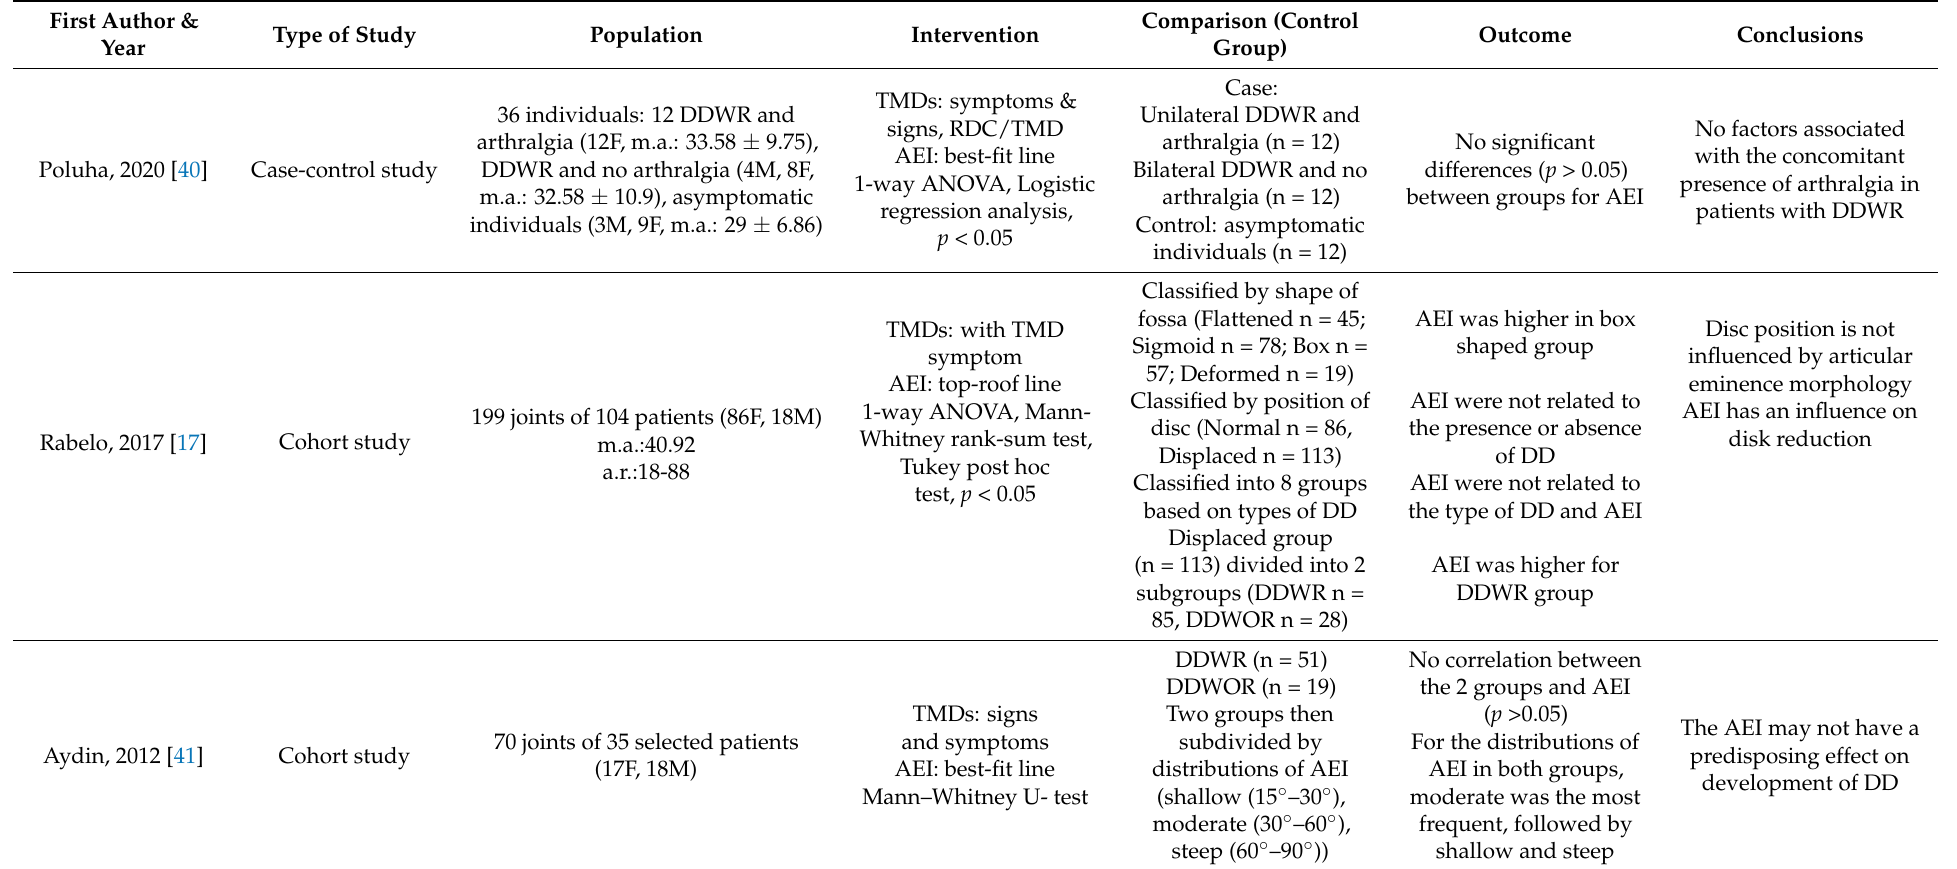
Table 3. Summary of findings from studies of TMDs and AEI with